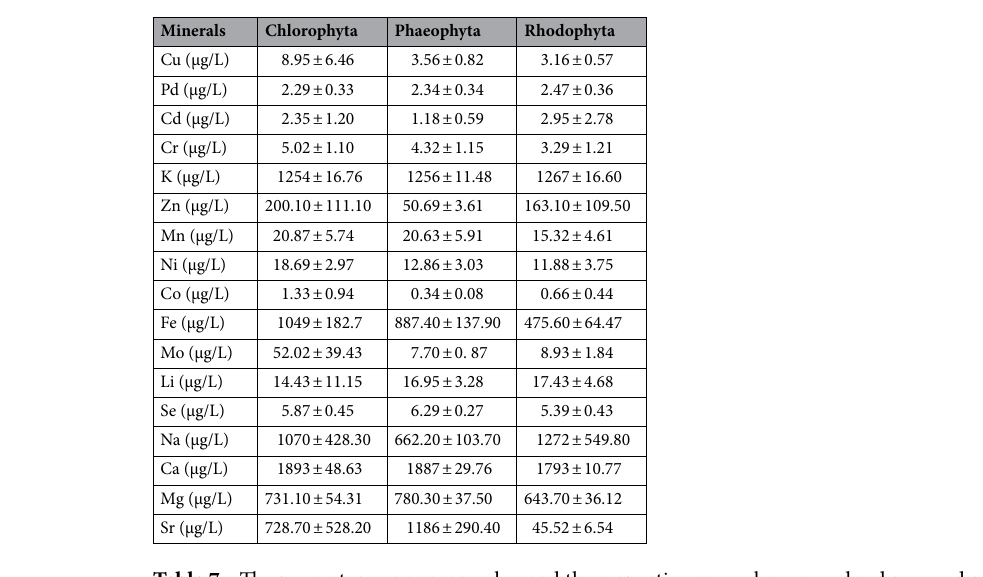
Table 7. The percentage as a mean value and the respective green, brown and red seaweed group (mean ± SE) %. Data are expressed as values: mean ± SE of three replicates and analysed by one-way analysis of